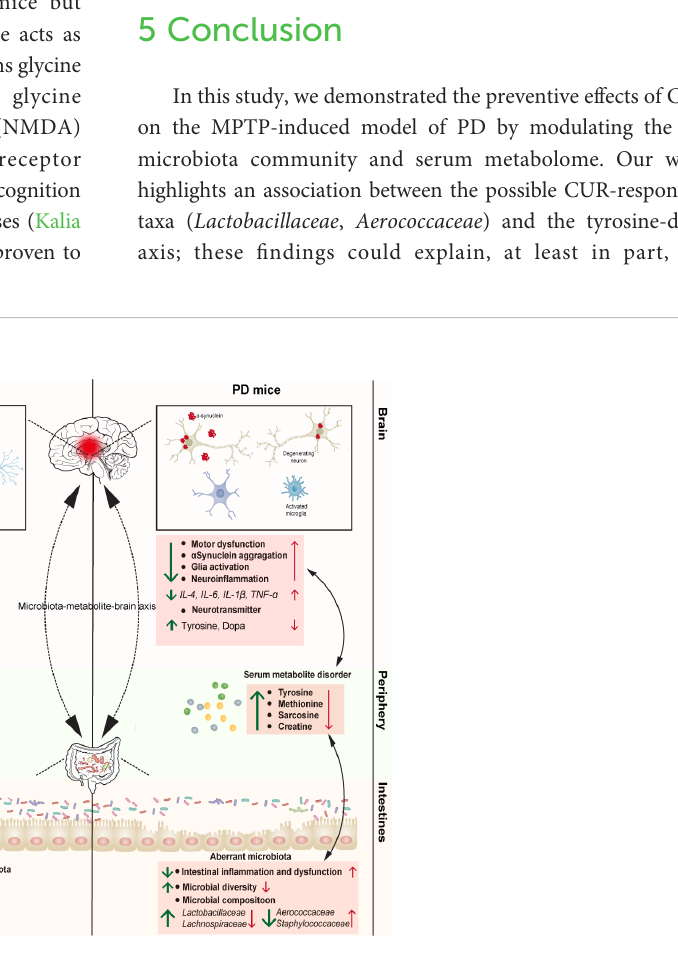
FIGURE 7 The mechanism by which CUR modulates the gut microbiota-metabolite axis in MPTP-induced PD mouse model. Red arrow represents the changes induced by MPTP treatment, and green arrow indicates the alterations after CUR